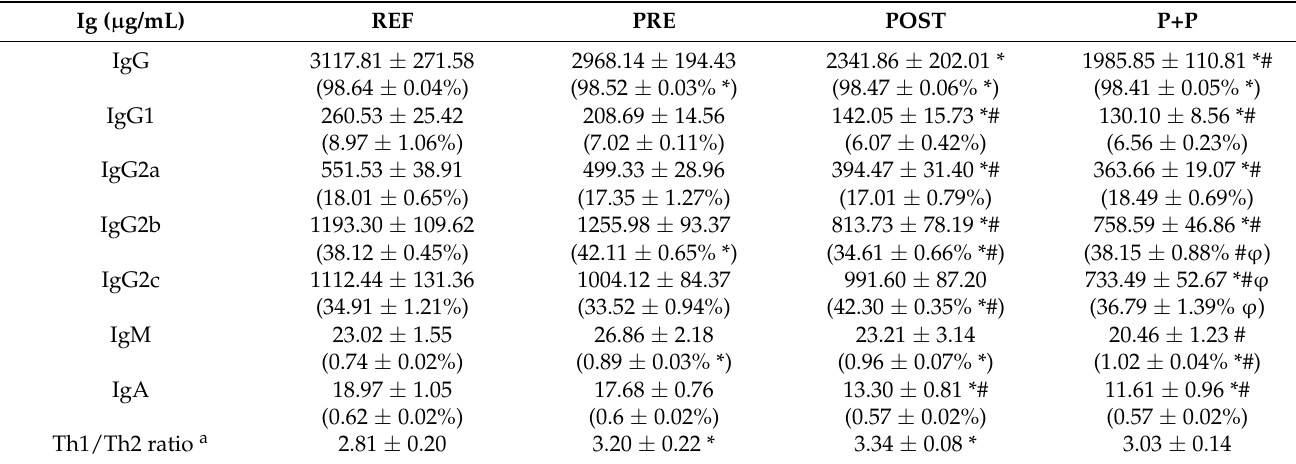
Table 2. Concentration of immunoglobulins in plasma at the end of the study (day 16). Ig ( µ